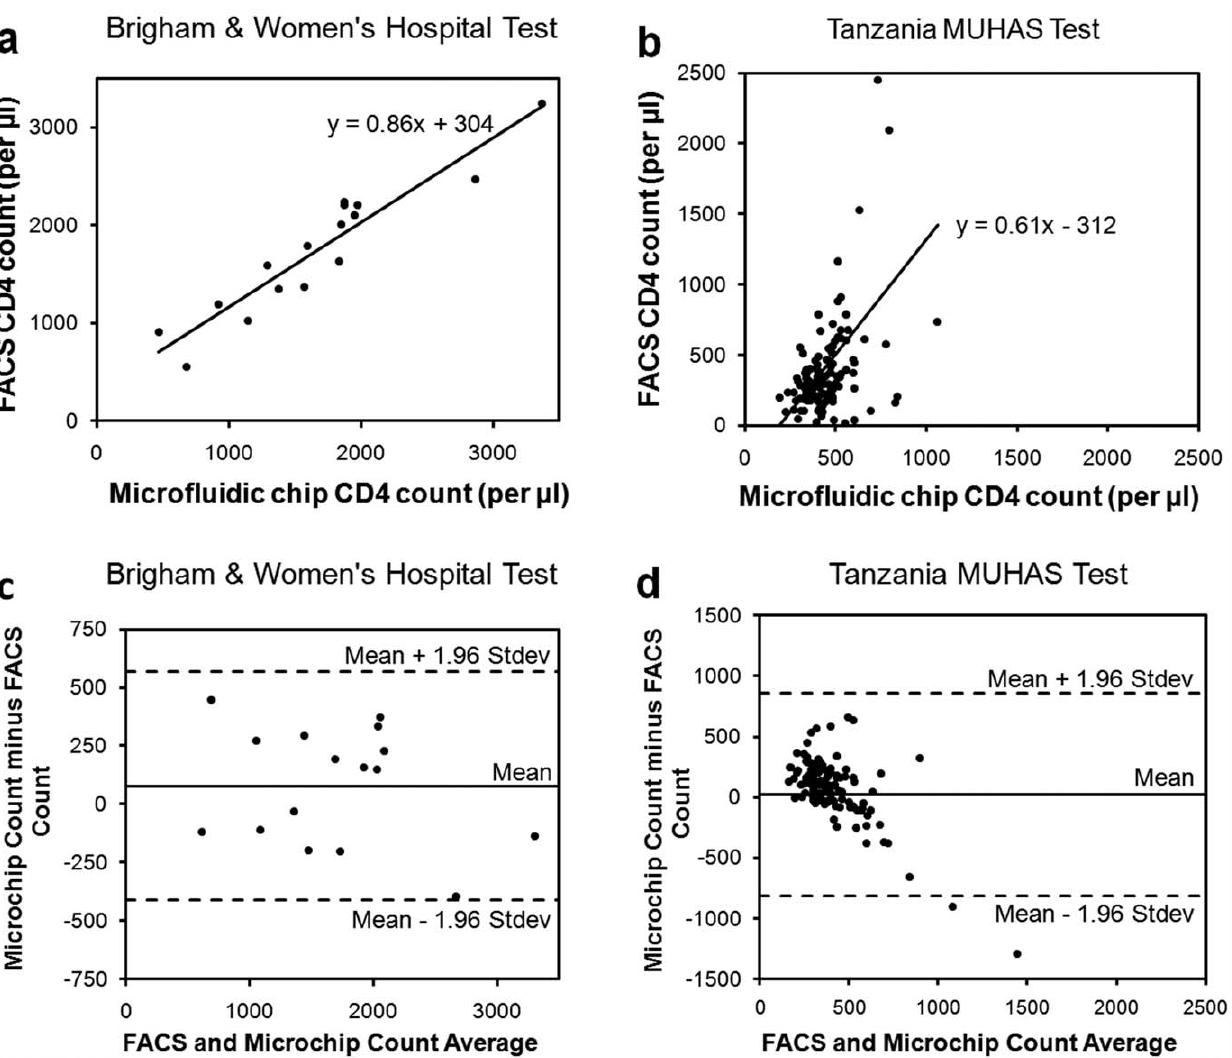
Figure 4. Comparison of microchip and Fluorescent Activated Cell Sorting (FACS) CD4 + T-lymphocyte counts for HIV-infected patient whole blood samples. The measurements were performed at BWH (Brigham and Women’s Hospital, Boston, MA) and MUHAS (Muhimbili University of Health and Allied Sciences, Dar es Salaam, Tanzania). FACSCalibur counts were used as the gold standard to compare and validate the microchip counts. ( a ) Microchip measurements highly correlated with FACSCalibur measurements when conducted at an established hospital setting at BWH (y=0.86x + 304, correlation coefficient: 0.94, p , 0.01). ( b ) When the microchips were shipped to Tanzania and the measurements were performed at MUHAS, a correlation between the microchip CD4 counts and the FACS counts were observed (y=0.61x + 312, correlation coefficient: 0.49, p , 0.01). ( c ) Bland-Altman Analysis between the microchip and FACS counts did not display an evidence for a systematic bias for BWH measurements. The mean bias was + 76 cells per m L of blood in microchip counts compared to FACS counts at BWH. ( d ) Bland-Altman Analysis showed a bias towards higher measurements in MUHAS results, while the mean bias was as low as + 23 cells per m L of blood in microchip counts compared to FACS